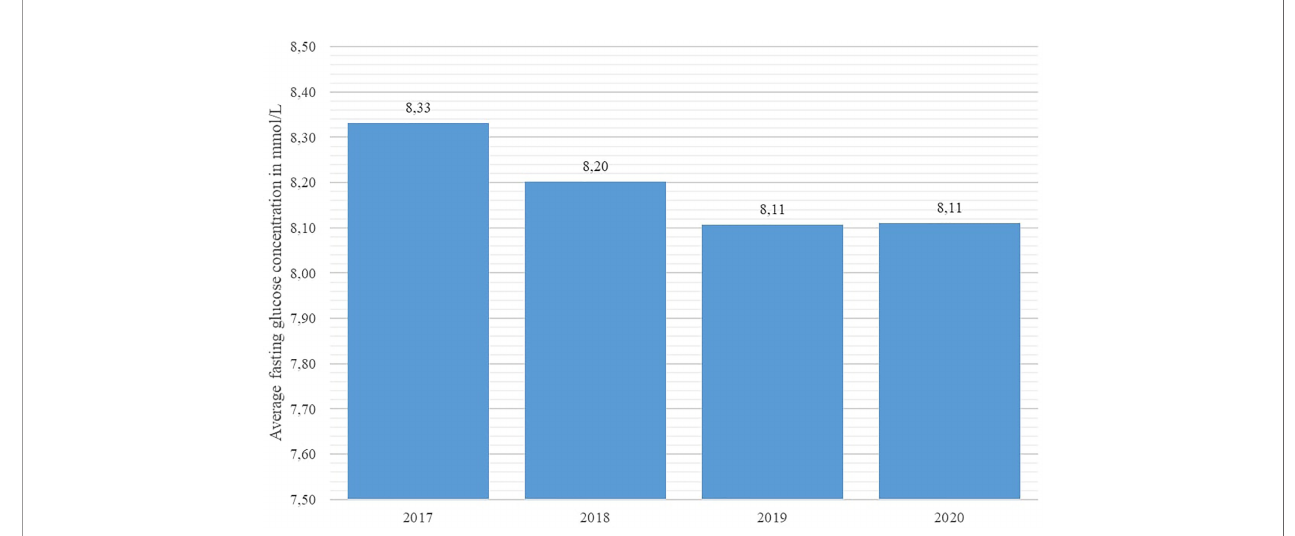
FIGURE 6 | Average fasting glucose values in diabetes patients in Croatia per year, 2017 –